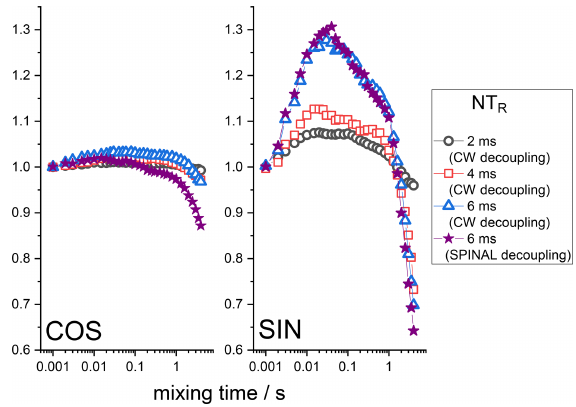
Figure 8. Normalized SIN and COS components of the 15 N CSA CODEX mixing time dependence in BOC glycine at different NT R . MAS 20kHz, 108kHz CW or SPINAL 1 H decoupling during the de(re)phasing periods, Z -filter delay 100ms, CP contact time 3ms.